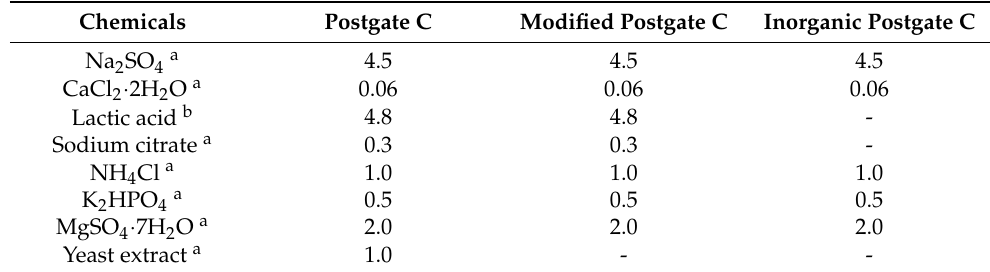
Table 1. Chemical composition of the commonly used Postgate C [26], modified Postgate C and inorganic Postgate C solutions.